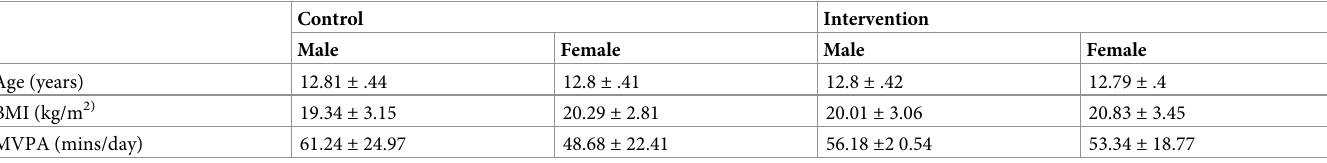
Table 1. Baseline characteristics (mean ± standard deviation) by gender and intervention